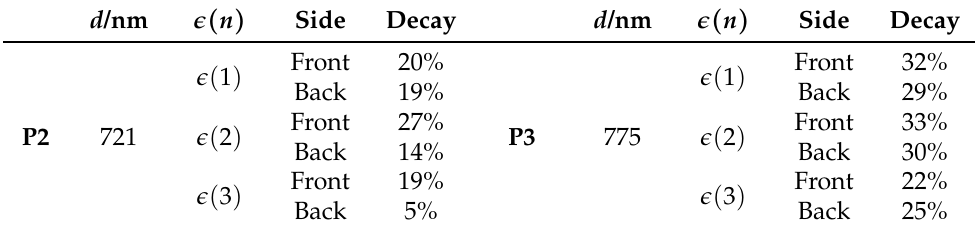
Figure 7. Long-term polarimetric measurements for a total exposure time of 700min. ( a , c ): P2 . ( b , d ): P2 . “B” means Back for irradiating sample from glass-side, “F” means Front for irradiating from azo-side. (cid:101) ( n ) denotes the ellipticity combination of excitation and analysis laser according to Table 2. Table 3. Decay from ∆ ψ max to last value of ∆ ψ t = 700min . For ellipticity combinations see Table 2 .